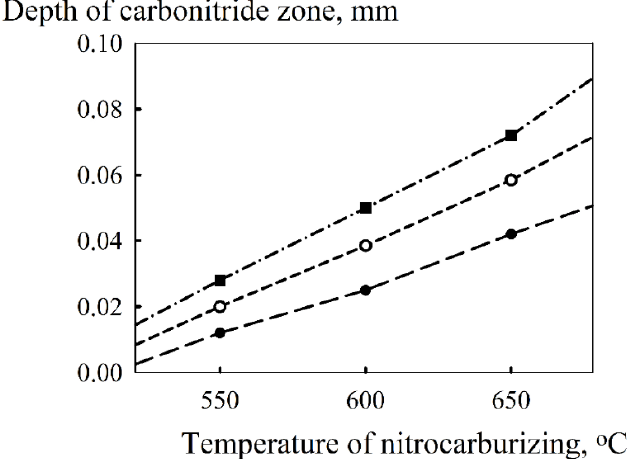
Figure 3. Dependencies of the carbonitride zone depth in nitrocarburized layers of Steel 60Si2Cr on nitrocarburizing temperature for di ff erent duration: ● —1 h; ○ —3 h; ■ —5 h.